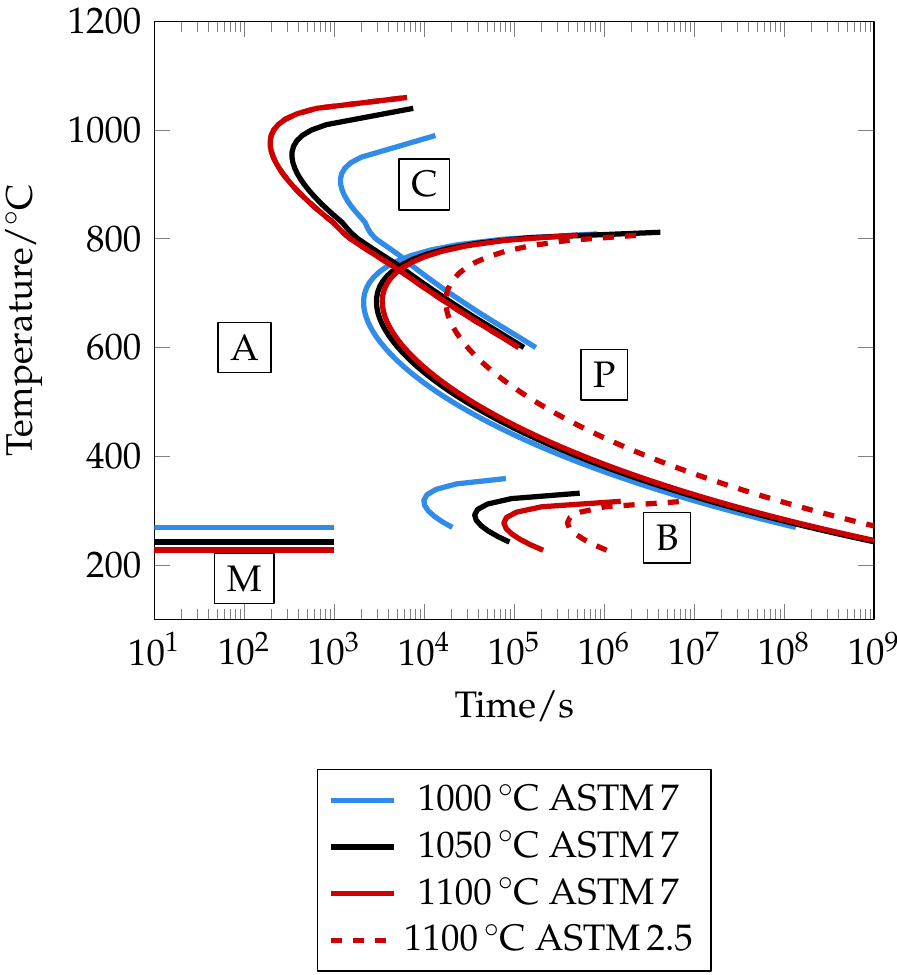
Figure 9. TTT 1 % amount transformed (gen- eral steel and stainless steel mode for Carbides) ASTM 7 calculated by JMatPro R The abbreviations in the graph mean the fol-